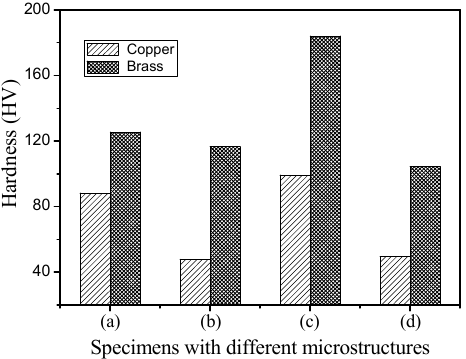
Figure 5. Variations of grain size of specimens with different microstructures.